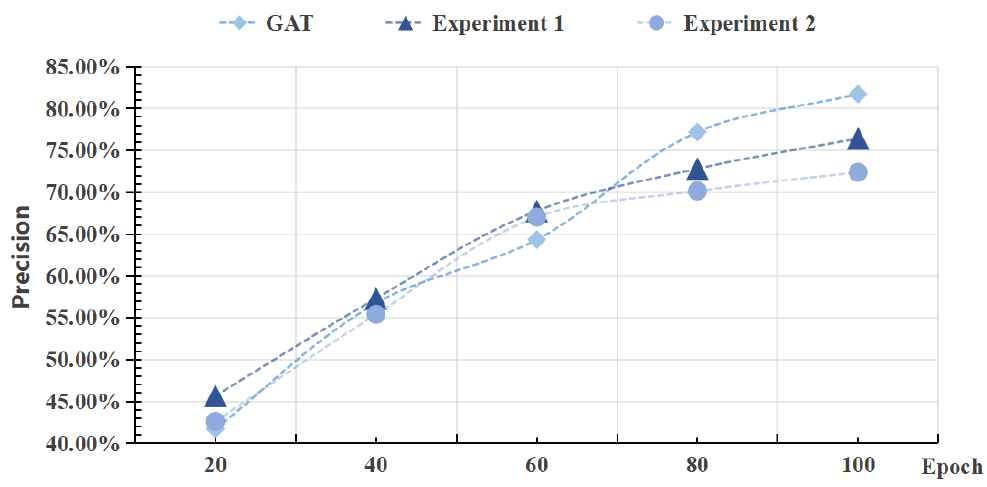
Figure 17. The experimental